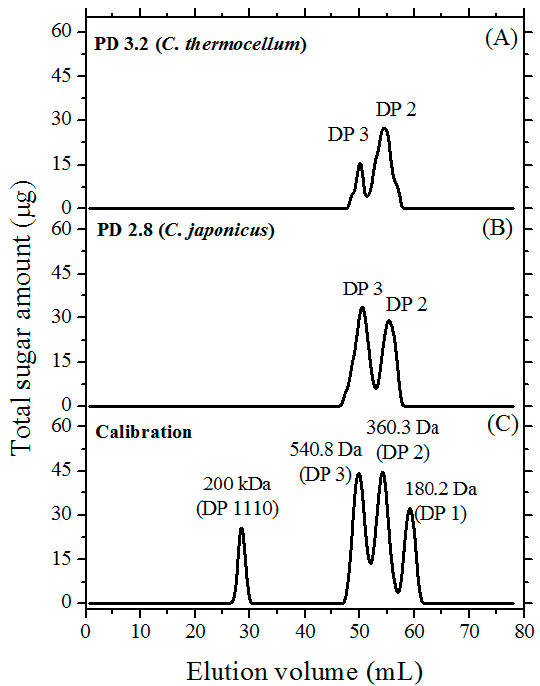
Figure 5. Size-exclusion chromatography (Bio-Gel P2) profiles of reactions optimized for generation of PGOs with DP 2.8–3.2. ( A ) galactanase from C. thermocellum ; ( B ) galactanase from C. japonicus ; and